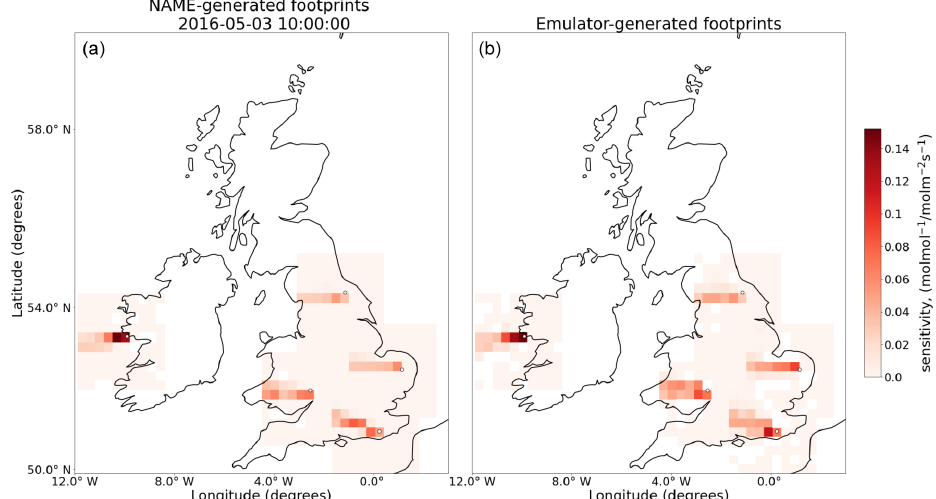
Figure 2. NAME-generated footprints (a) and emulator-generated footprints (b) for the same date (3 May 2016, 10:00:00GMT) and the five sites in the UK and Ireland (Mace Head, Bilsdale, Ridge Hill, Heathfield, and Tacolneston, marked with a white dot). In the cells where domains for different emulators overlap, the sensitivity represents the maximum value across emulators for that